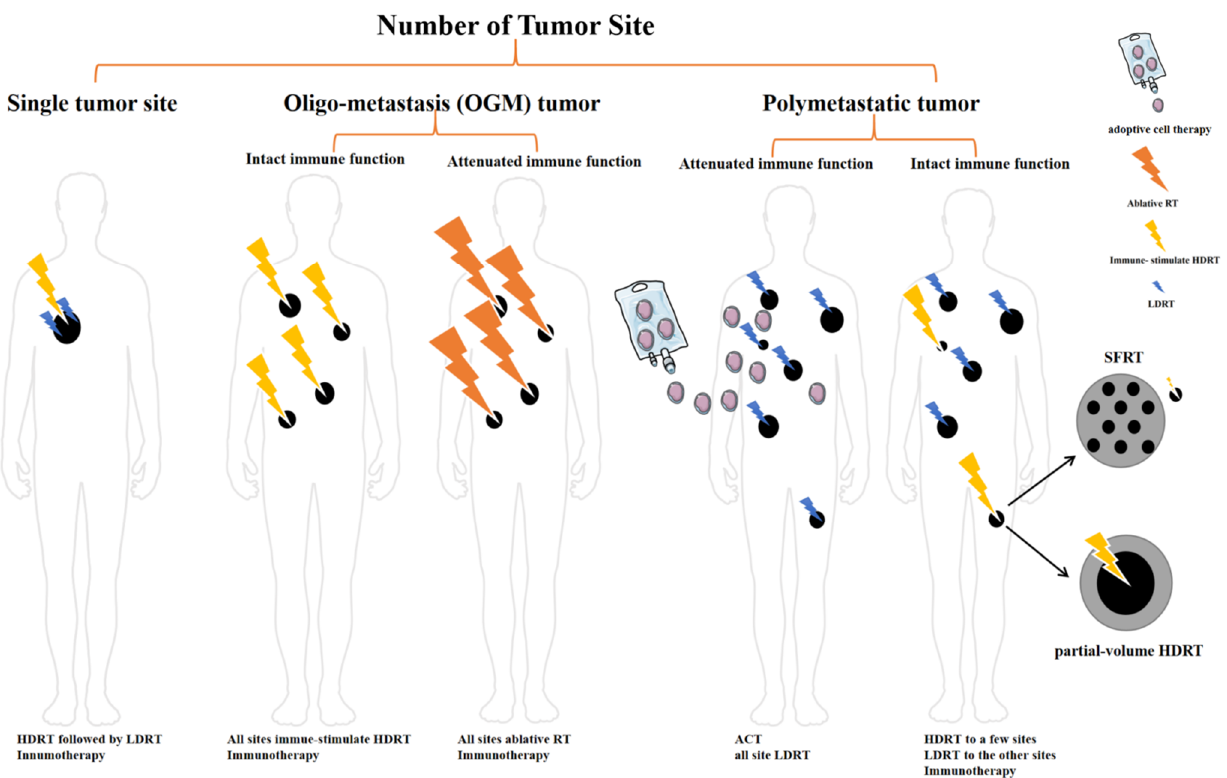
Figure 2. A decision tree of personalized treatment choices of patients with different tumor burden and immune status.